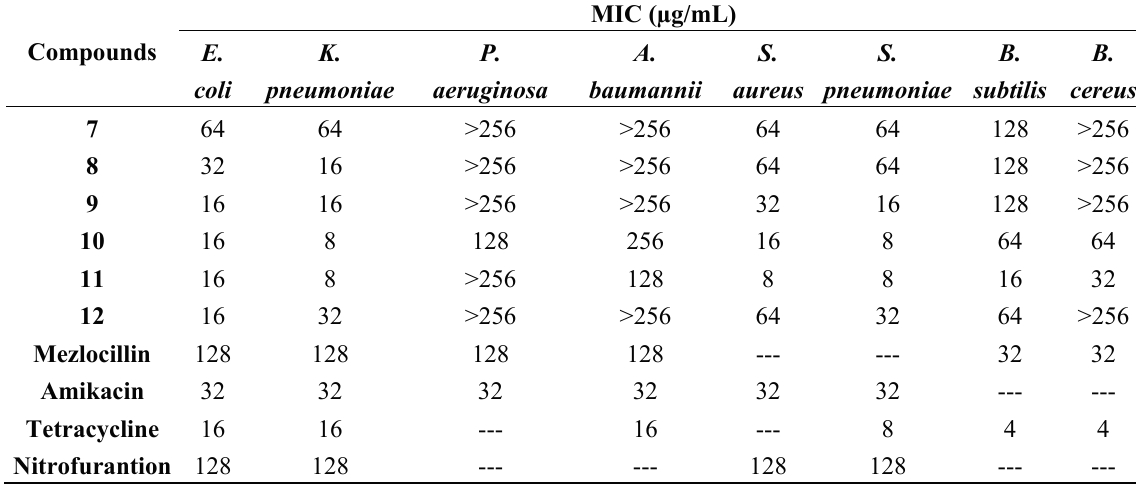
Nitrofurantion 128